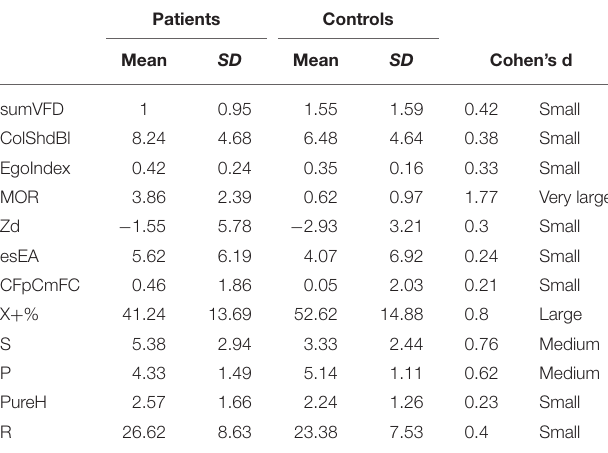
TABLE 2 | Scores of S-Con components by group.